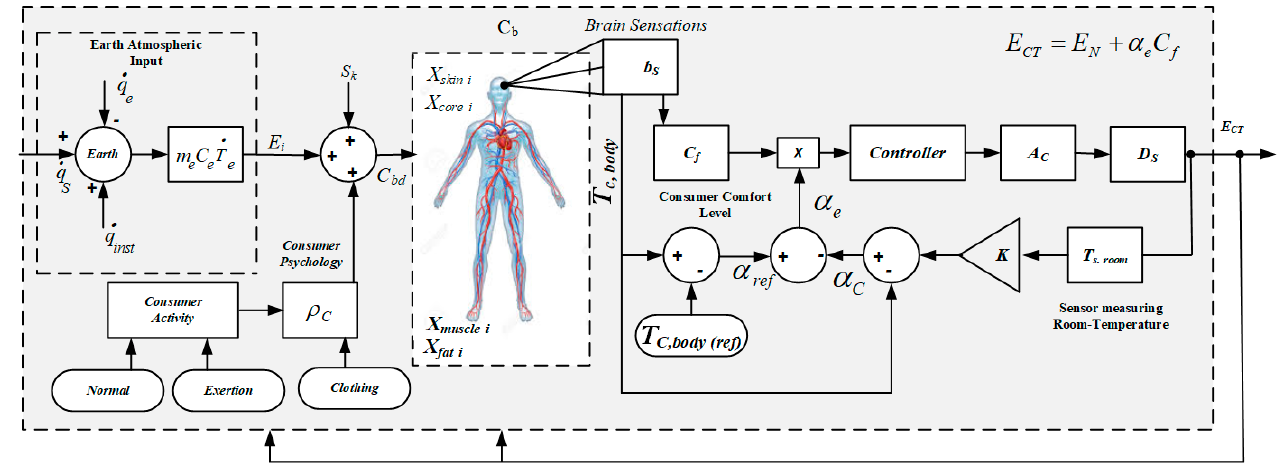
Figure 3. Closed Loop Feedback Controller-based switching and actuating system.